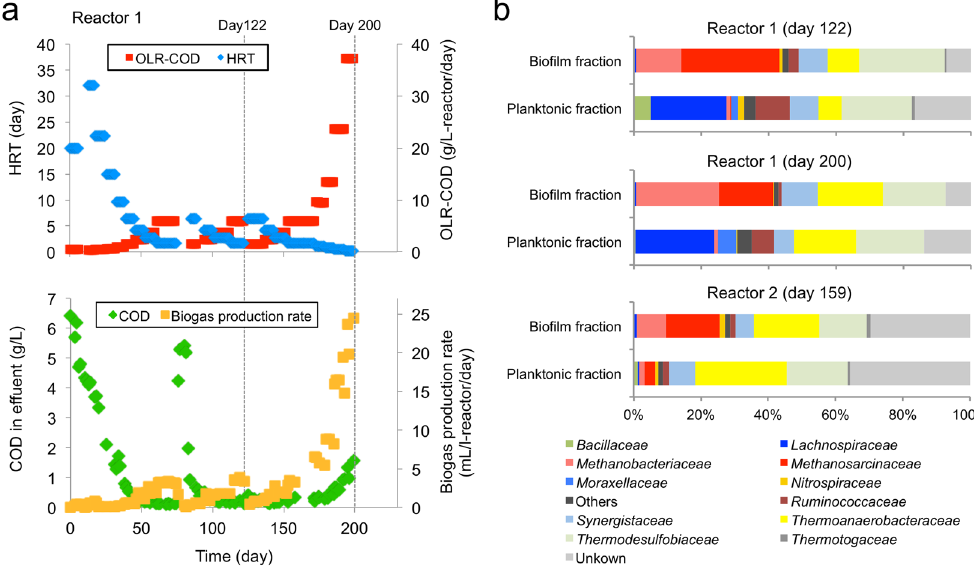
Figure 1. Bioreactor operation and enrichment of methanogenic consortia. ( a ) Time course of OLR, HRT, COD in effluent, and biogas production rates in reactor 1. Data on the operation of reactor 2 are shown in Supplementary Fig. S2. ( b ) Relative abundances of major archaeal and bacterial families in reactor 1 (days 122 and 200) and reactor 2 (day 159) based on pyrosequenced 16S rRNA gene